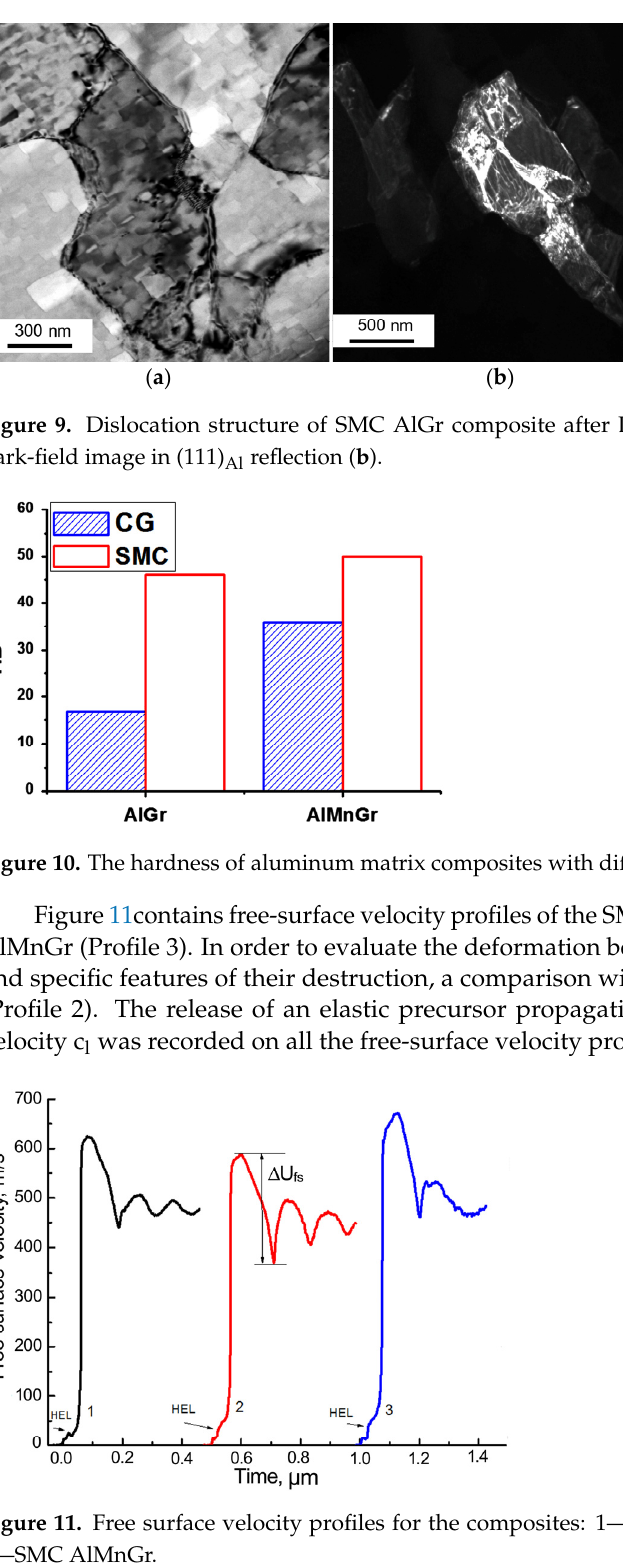
Figure 11. Free surface velocity profiles for the composites: 1—SMC AlGr; 2—CG AlMnGr; and 3— SMC AlMnGr. 3—SMC